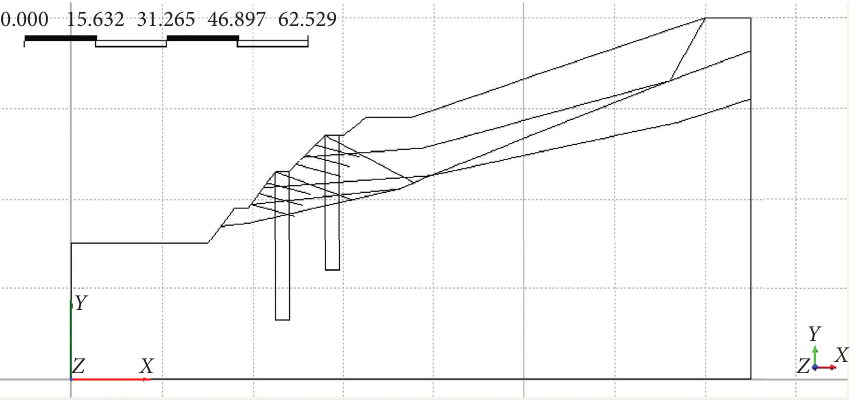
Figure 3: Geometric schematic of the K5 +420 slope section used for modelling.